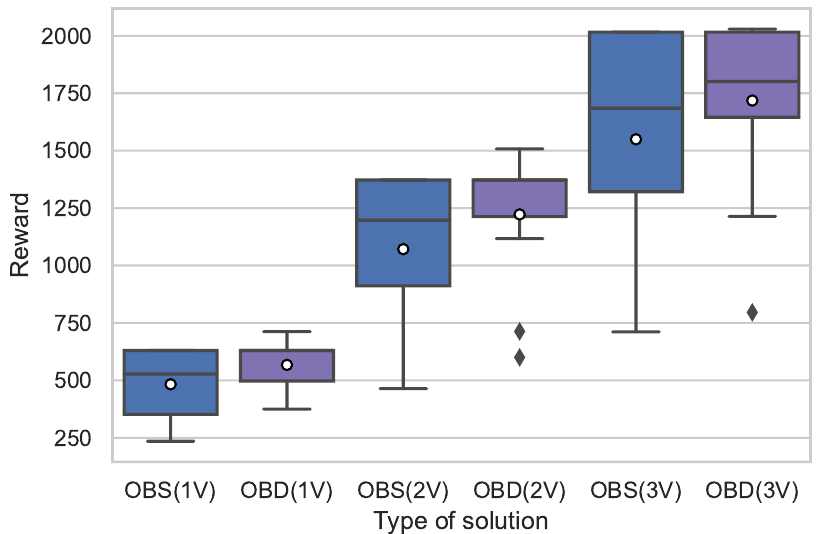
Figure 6. Reward obtained by each type of solution for different fleet